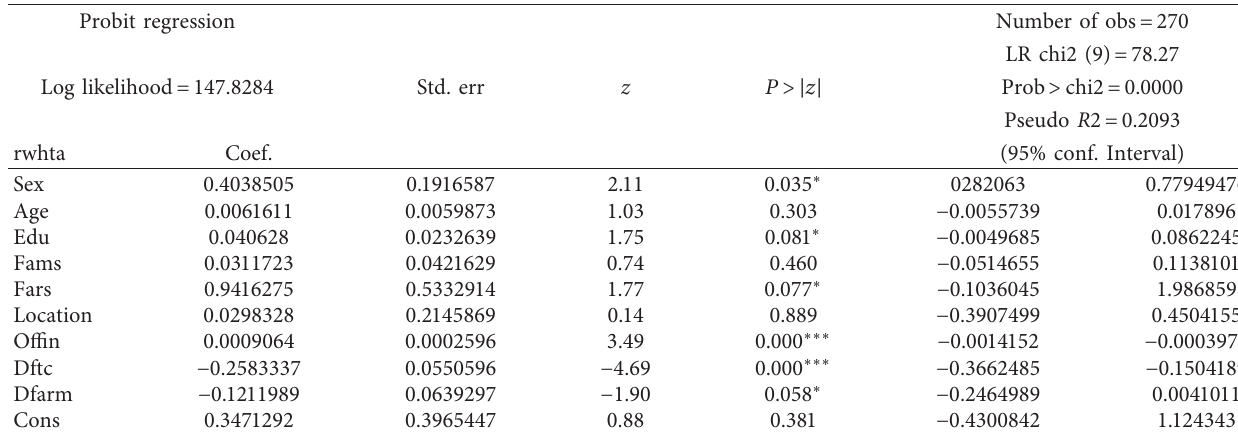
Table 4: Econometric